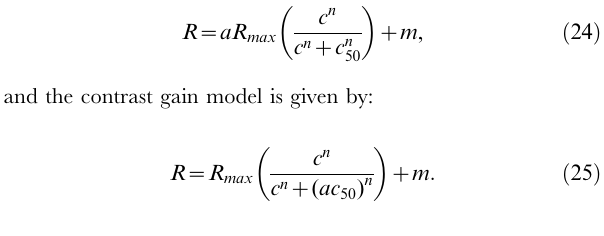
PLOS Computational Biology |